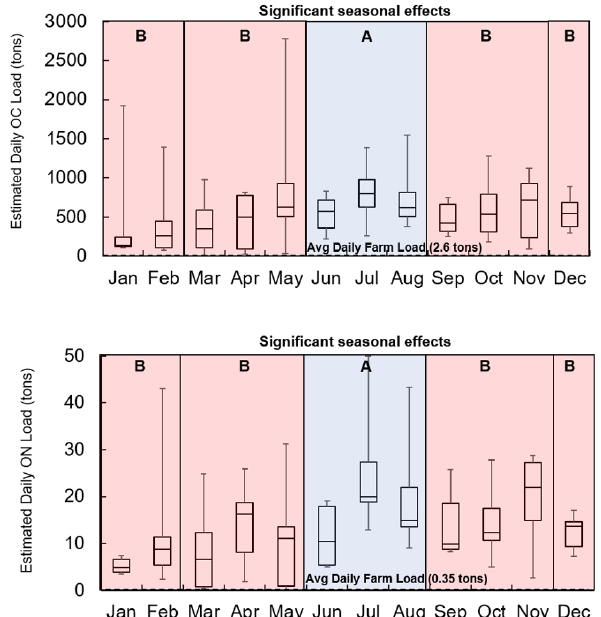
Figure 4. Daily OC and ON loading (tons) for each month based on estimated daily flows and concentrations of OC and ON measured at the Gordon River mouth from 2015 to 2021. Note the large variation in the month of May is driven by large flows in years 2015 and 2016. Dashed line indicates average daily OC and ON loading from farm feed inputs based on 10000t annual production, feed conversion rate = 1.3, assimilation rate of 85%, 49% feed carbon content, and 6.7% feed nitrogen content. Post hoc groupings show significantly higher loads in winter depicted as blue boxes (denoted Group A) relative to other seasons as red boxes (denoted Group